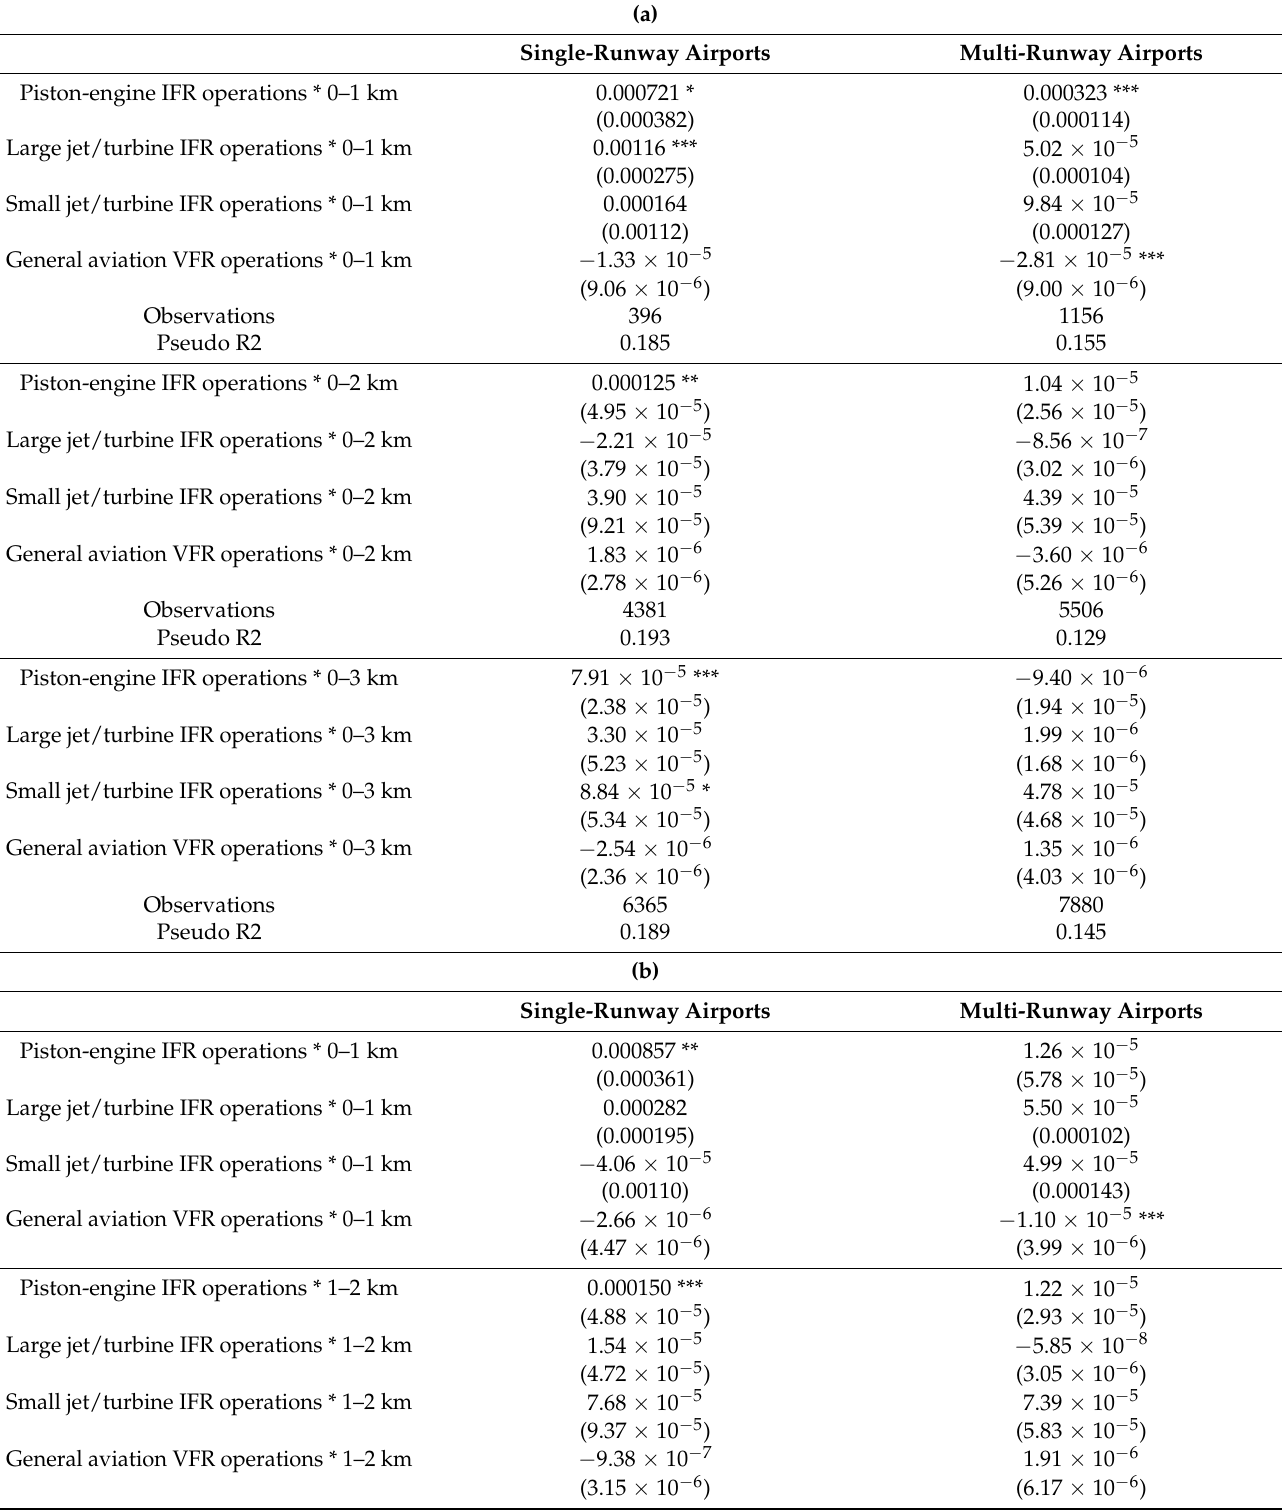
Table 4. ( a ) Key coefficient results from separate regressions with varying treatment cutoffs: Effect of annual flight operations on cardiovascular mortality near TFMSC airports. ( b ) Key coefficient results from single regression with 3 km treatment cutoff: Effect of annual flight operations on cardiovascular mortality near TFMSC